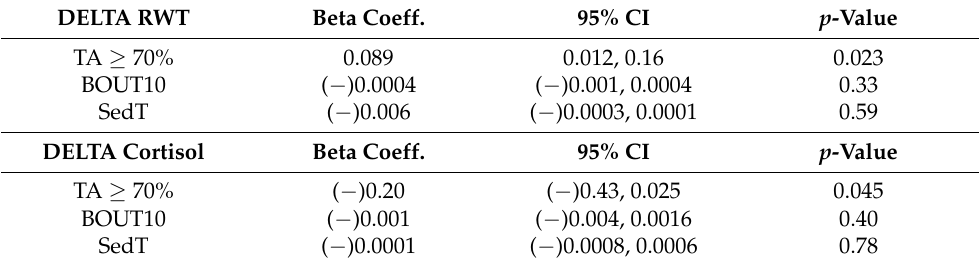
Table 4. Correlates of RWT and cortisol delta absolute change.